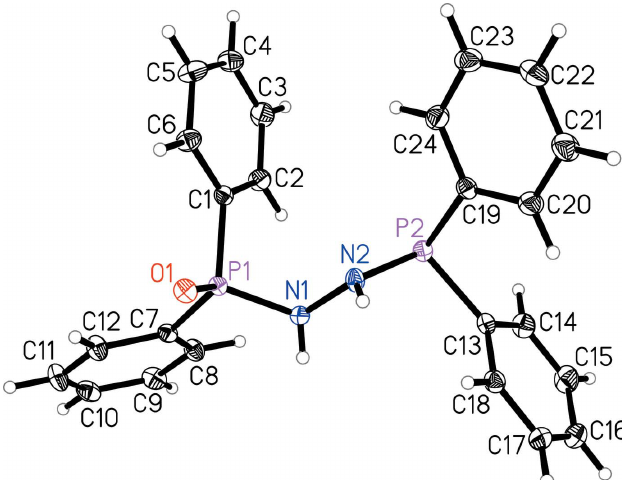
Figure 1 The molecular structure of the title compound with displacement ellipsoids drawn at the 30% probability